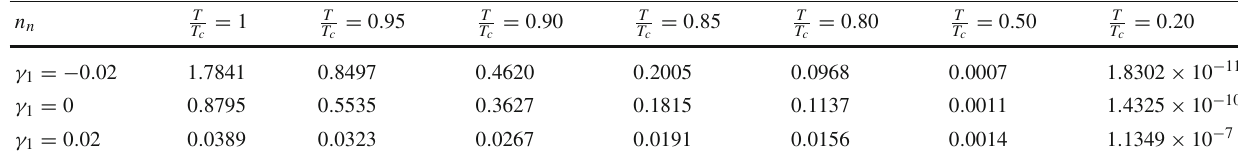
Table 6 The normal fluid density n n in the superconducting phase for the different temperature in 6 derivative theory ( γ =